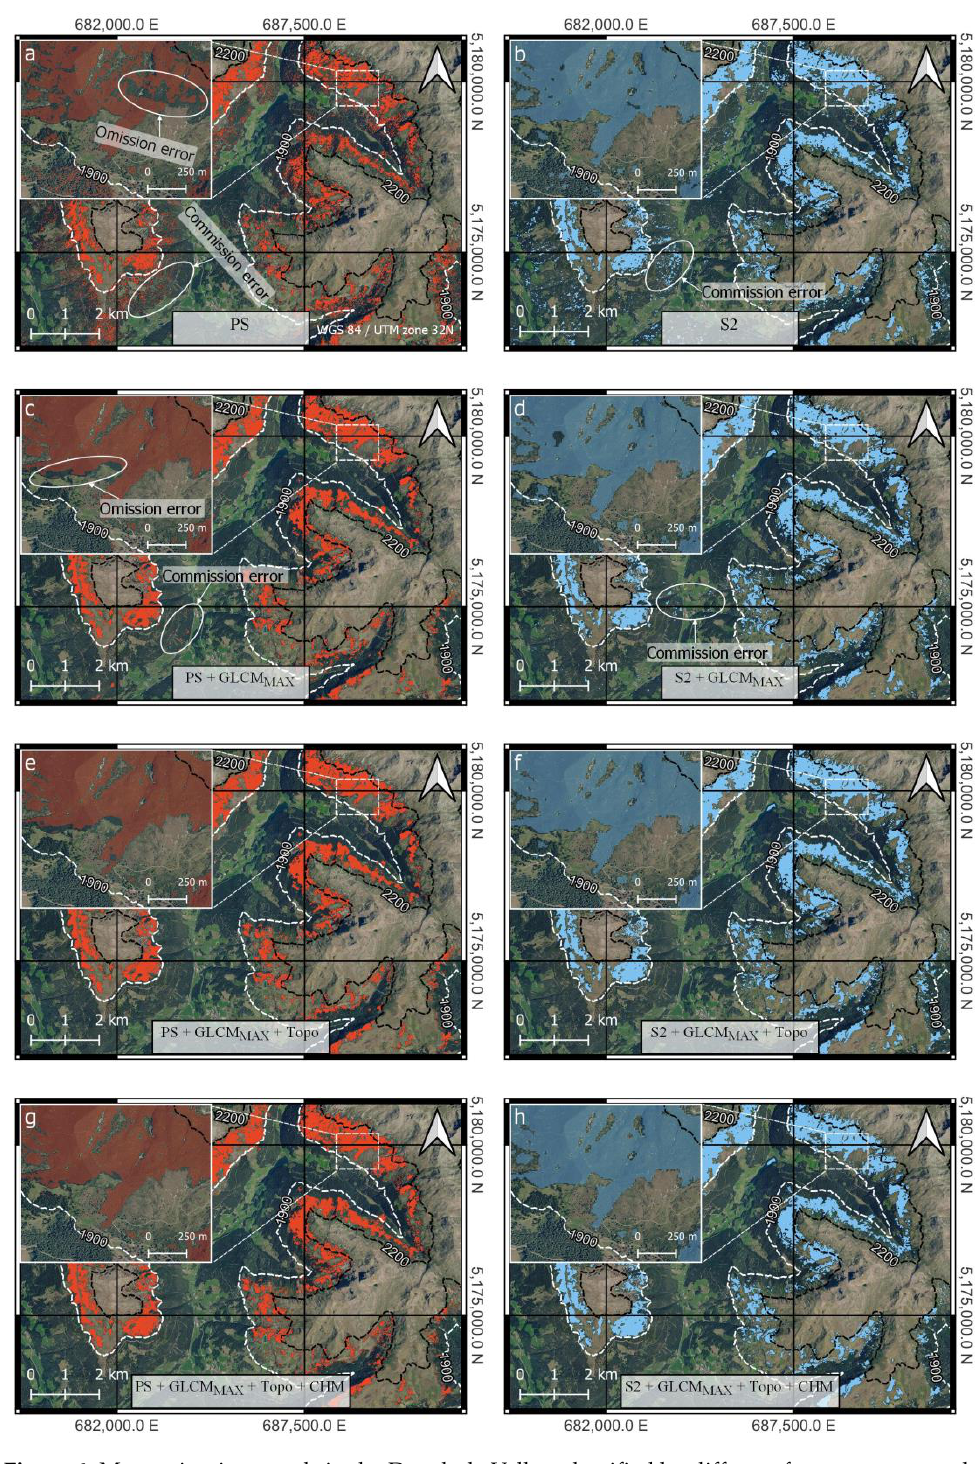
Figure 6. Mountain pine stands in the Durnholz Valley, classified by different feature space combi- nations. ( a , c , e , g ) Classification results based on PlanetScope feature spaces. Mountain pine areas derived from PlanetScope feature spaces are colored in red. ( b , d , f , h ) Classification results based on Sentinel-2 feature spaces. Mountain pine areas derived from Sentinel-2 feature spaces are colored in blue. Commission errors occur where pixels of other land cover classes are classified as mountain pines (false positive). Omission errors occur where mountain pine pixels are incorrectly not detected (false negative). Background: Orthophoto 2020 (Autonomous Province of Bolzano).